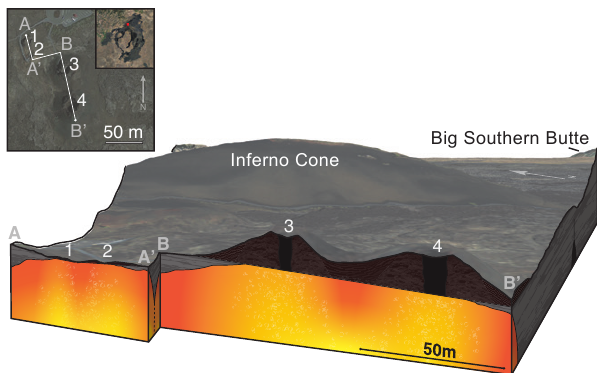
Figure 2: Cross section of four volcanic vents from Craters of the Moon (a location map for this area can be found on Figure 9). The inset map indicates the lo- cations of these four vent structures at the surface (la- beled 1-4), which were all emplaced during the same